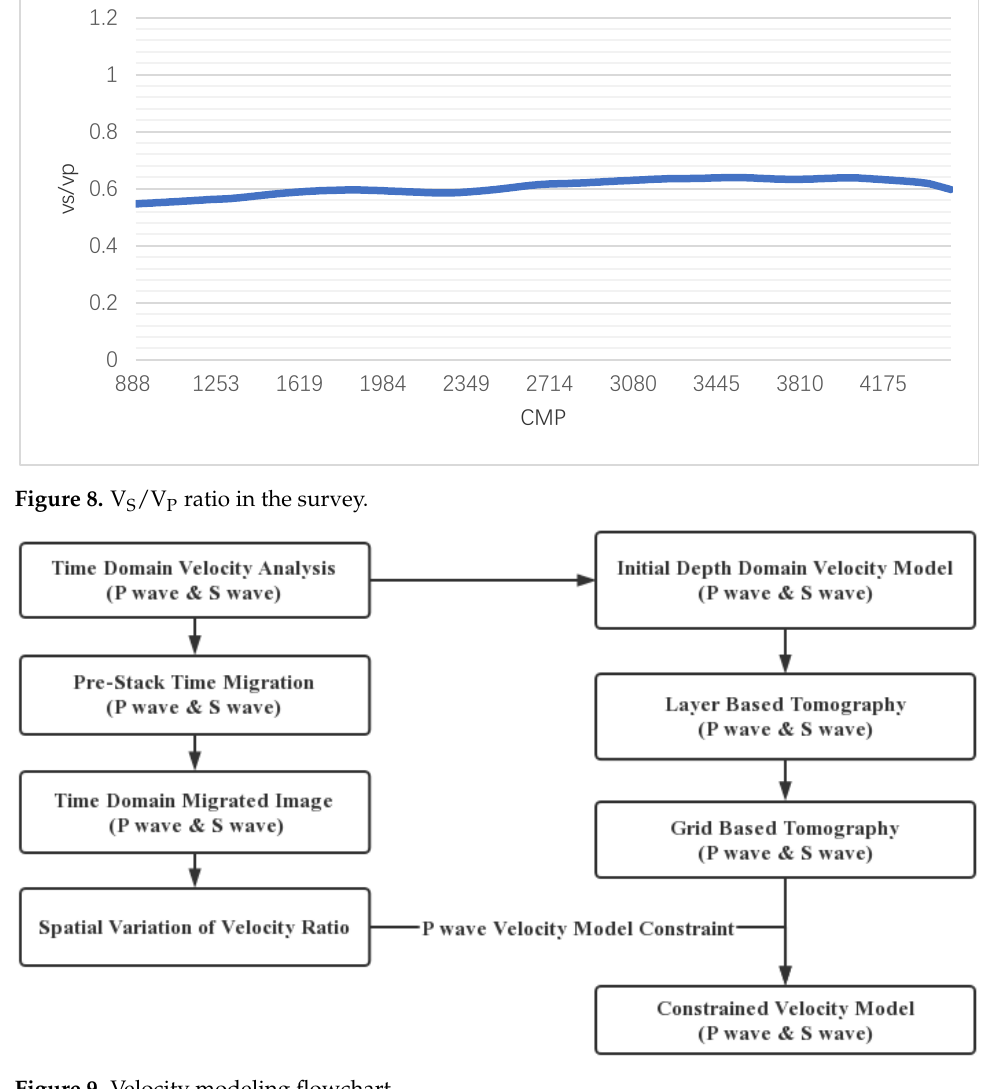
Figure 9. Velocity modeling flowchart.